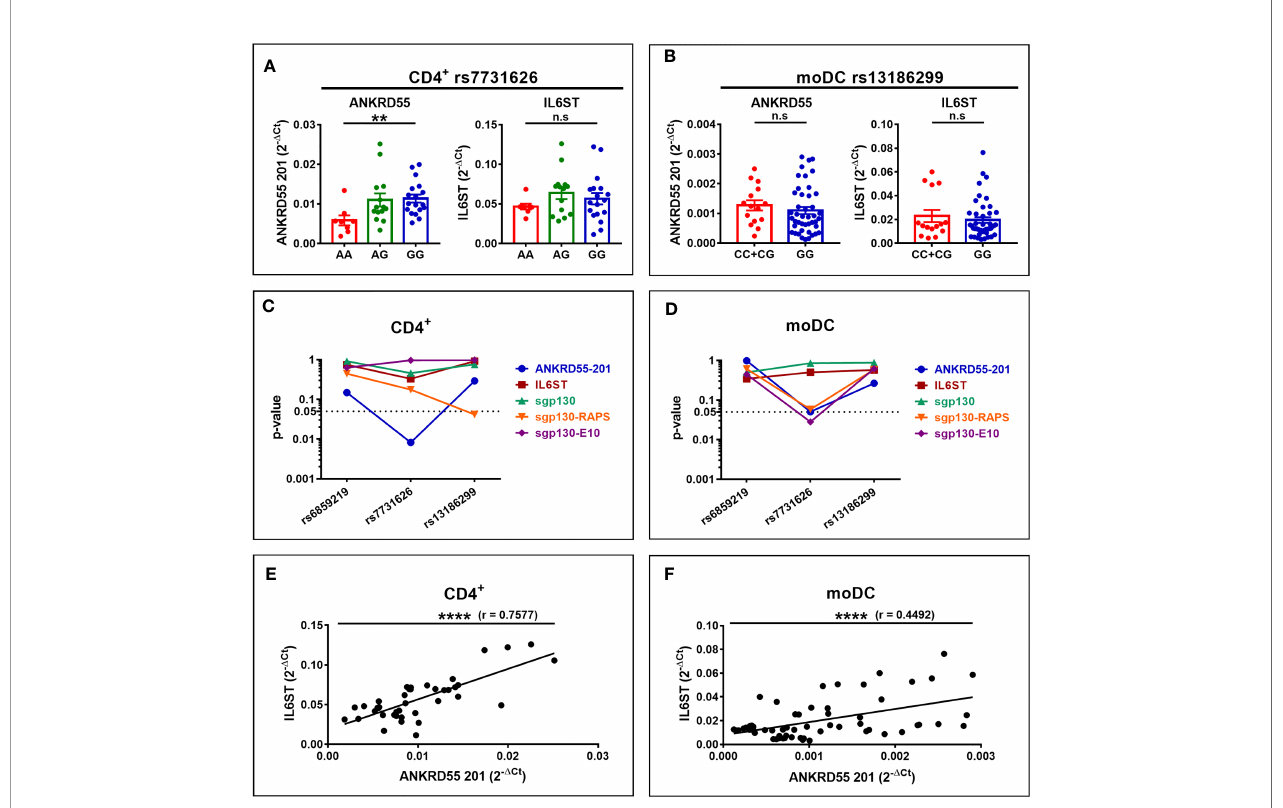
FIGURE 7 | Expression of ANKRD55 , IL6ST , and sgp130 isoforms in CD4 + T cells (A, C) and immature moDC (B, D) of MS patients. Panels (A, B) represent the effects of rs7731626 genotype in CD4 + T cells (mean ± SEM; n = 40, Cohort 2; Kruskal – Wallis test) and of rs13186299 genotype in moDC (mean ± SEM; n = 59, Cohorts 1 and 2; Mann – Whitney test), respectively. (C, D) Plot p -values for the three SNPs ’ effects on the expression of ANKRD55 , IL6ST , sgp130, sgp130-RAPS, and sgp130-E10 in CD4 + T cells and moDC (Mann – Whitney or Kruskal – Wallis tests). (E , F) represent Pearson correlation of ANKRD55 and IL6ST 2 - D ct values in CD4 + T cells and in moDC of MS patients from panels (A, B) , respectively. ** p ≤ 0.01, **** p ≤ 0.0001. n.s., not signi fi